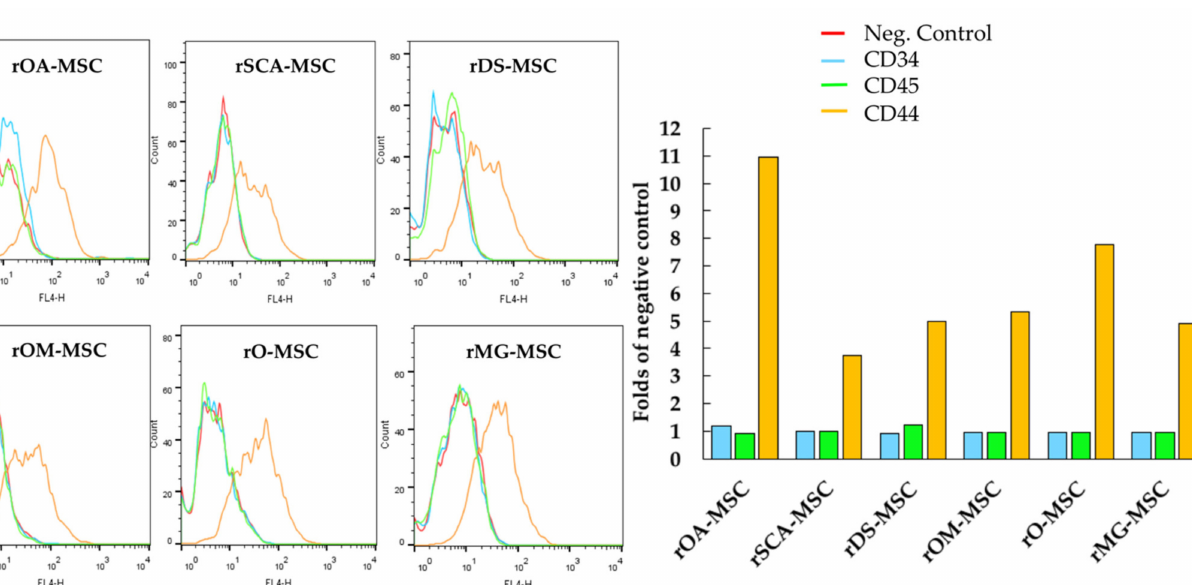
Figure 2. Analysis by flow cytometry of the expression levels of cell surface markers CD34, CD44, and CD45 in rOA-MSC, rSCA-MSC, rDS-MSC, rOM-MSC, rO-MSC and rMG-MSC. Plots depict the log of fluorescence intensity for each sample. Bar charts correspond to the mean fluorescence intensity (folds of negative control in the absence of primary antibody) for each